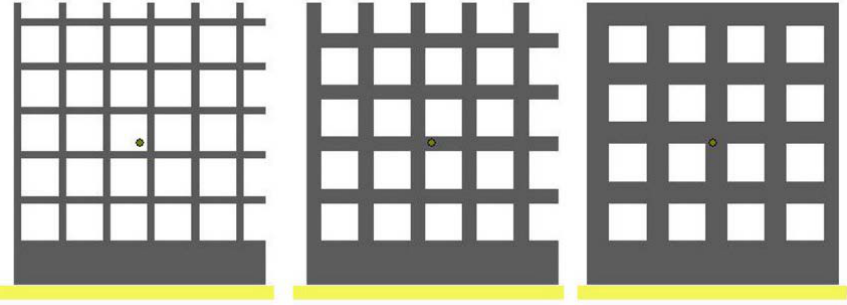
Figure 3. Porous designs with various strut thickness: 0.5 mm ( left ), 1 mm ( middle ), and 1.5 mm ( right ).